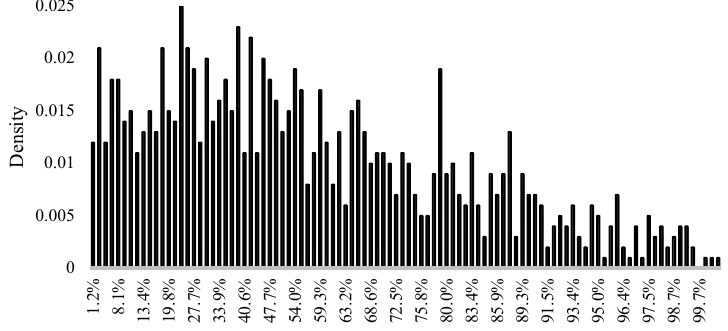
Figure 9. The probability density distribution of the annual growth rate of electricity price (source: authors calculation, using Crystal Ball software).